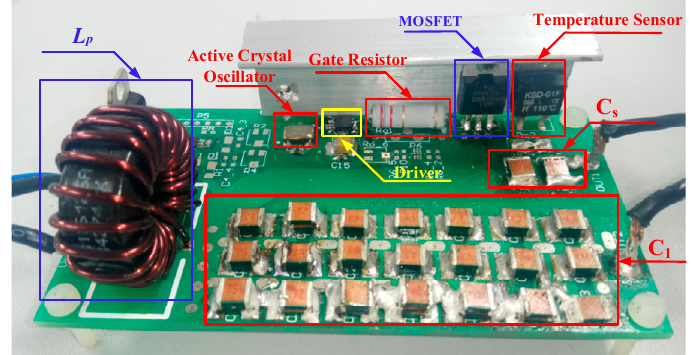
Figure 15. Experimental prototype of the Class-E inverter.